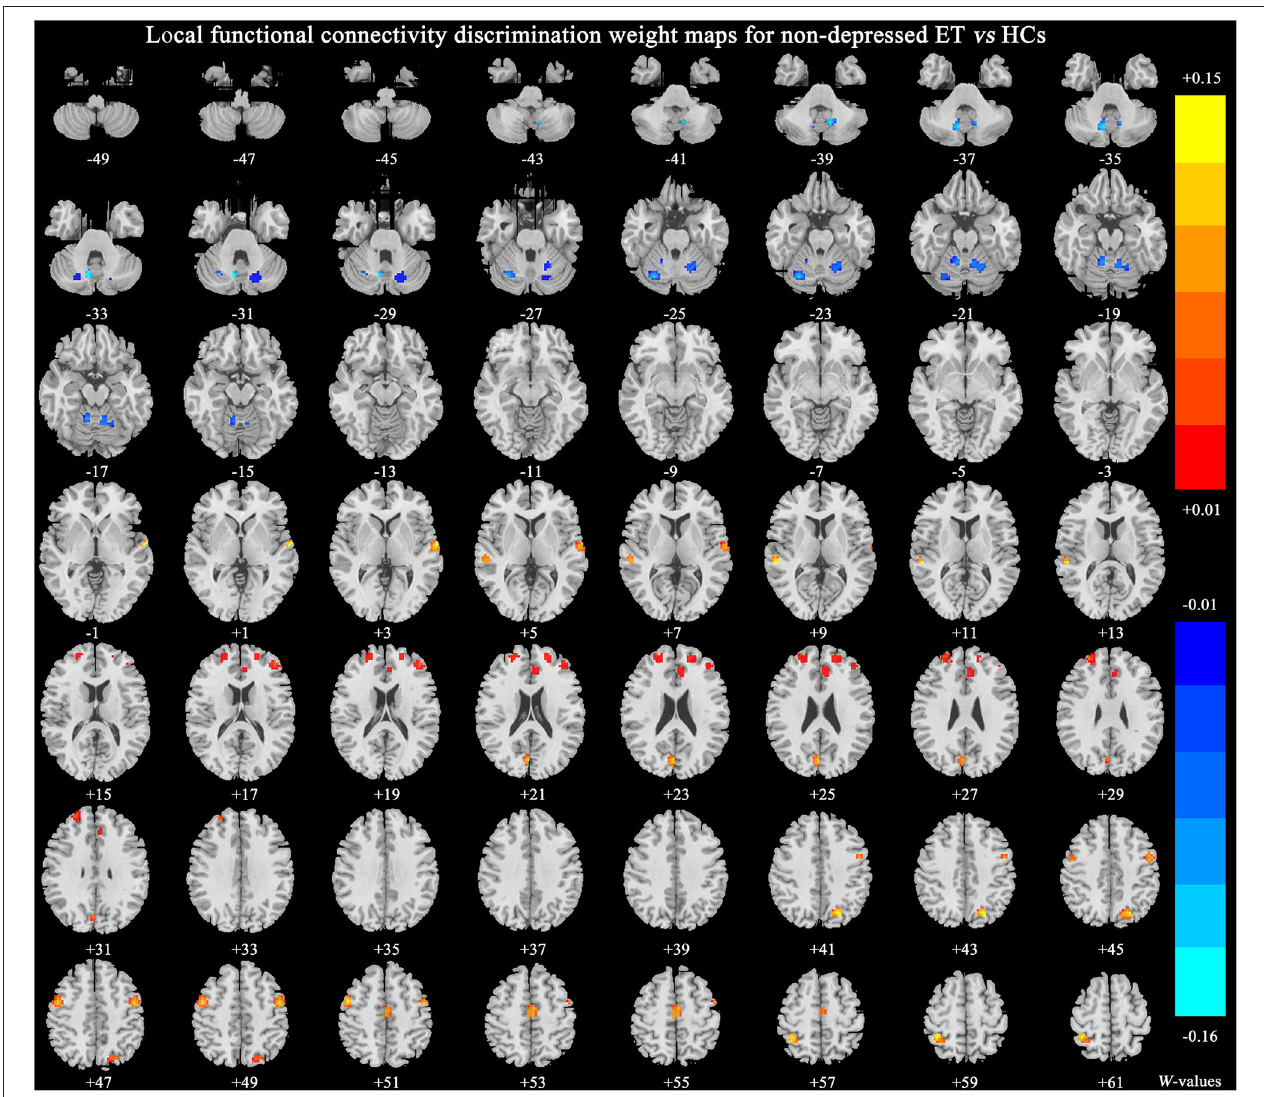
FIGURE 3 | The brain regions of significant discriminative features in the classification of non-depressed ET vs. HCs. ET, essential tremor; HCs, healthy